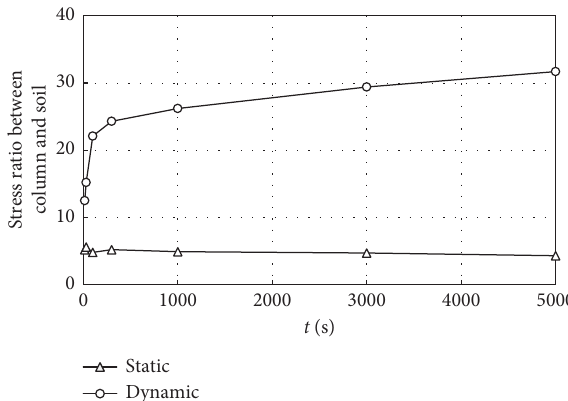
Figure 13: Stress ratio between the stone column and